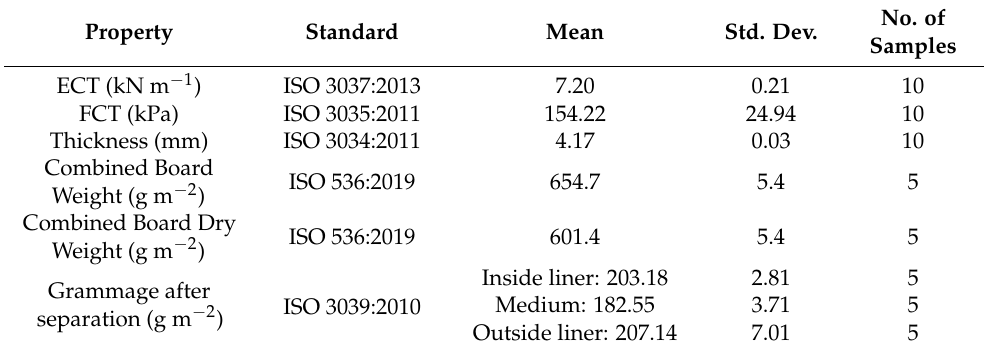
Table 7. Material properties of the corrugated board.